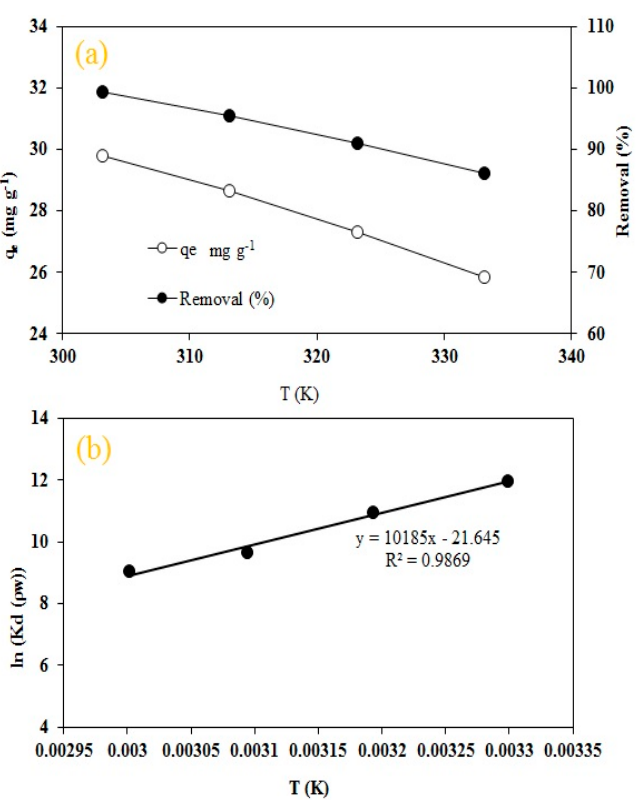
Figure 8. ( a ) E ff ect of temperature on MA-AC400 forRO16 adsorption; ( b ) Van’t Hof plot. Figure 8. ( a ) Effect of temperature on MA-AC400 forRO16 adsorption; ( b ) Van’t Hof plot.